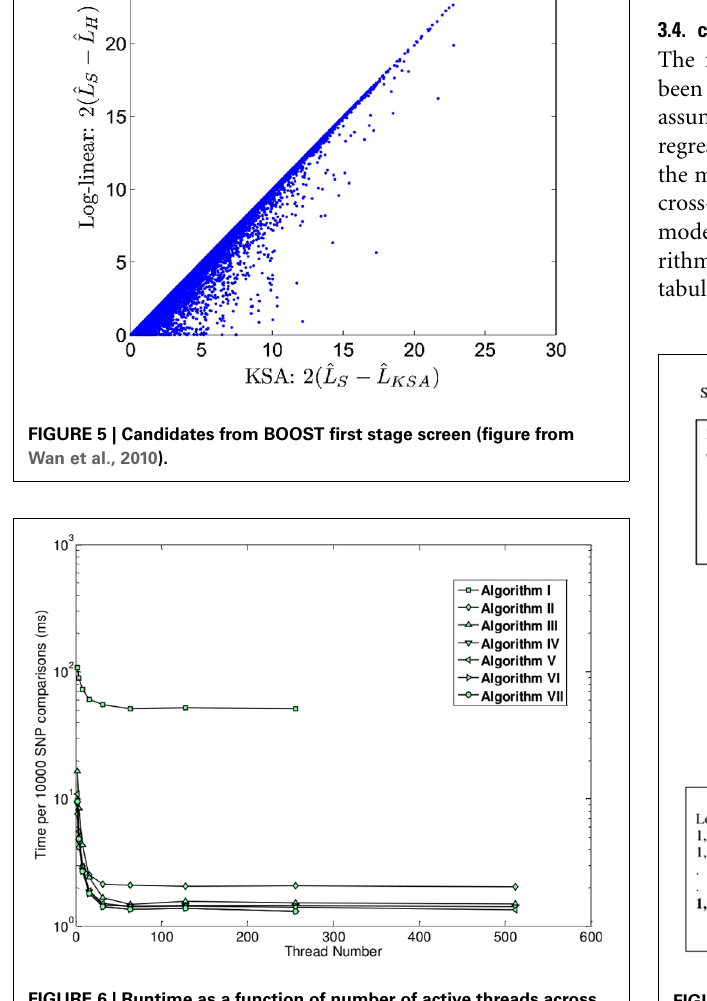
FIGURE 7 | Overview of MDR (figure from Oki and Motsinger-Reif,